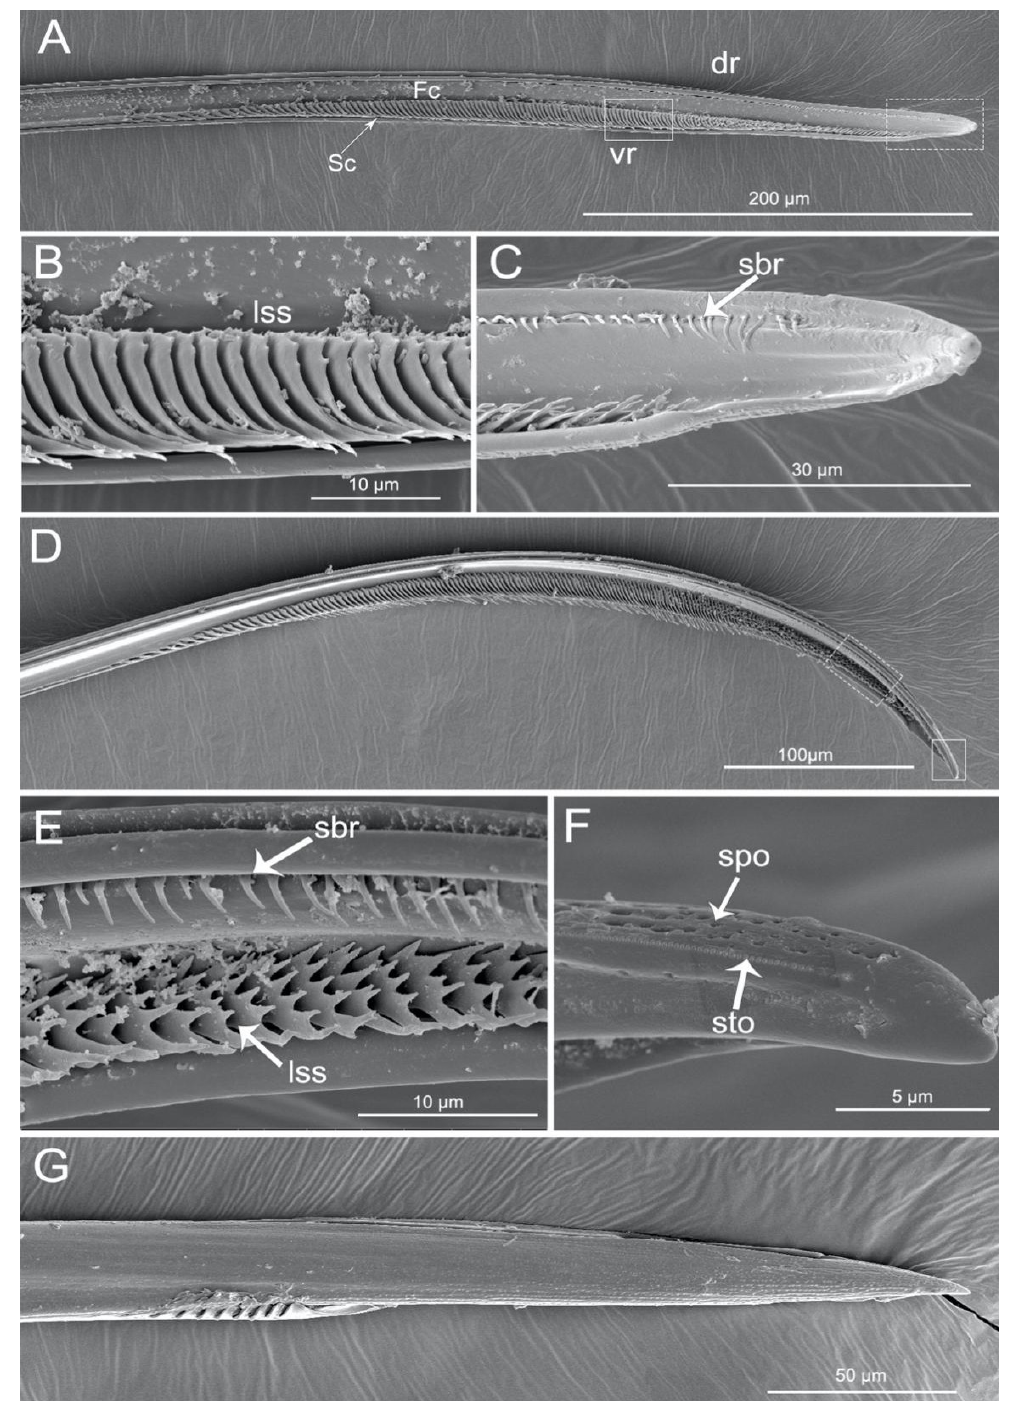
Figure 8. SEM of right maxillary stylets of Haematoloecha nigrorufa. A . Interior view; B . Enlarged view of box in ( A ); C . Enlarged view of box in ( A ), showing tip of right maxillary stylet (RMx); D , Lateral view; E. Enlarged view of box in ( D ); F. Enlarged view of box in ( D ), showing tip of right maxillary stylet (Rmx); G. External view; dr, dorsal row; vr, ventral row; lss, lamellate-shaped structures; sbr, short bristles; spo, small pore; sto, small tooth.